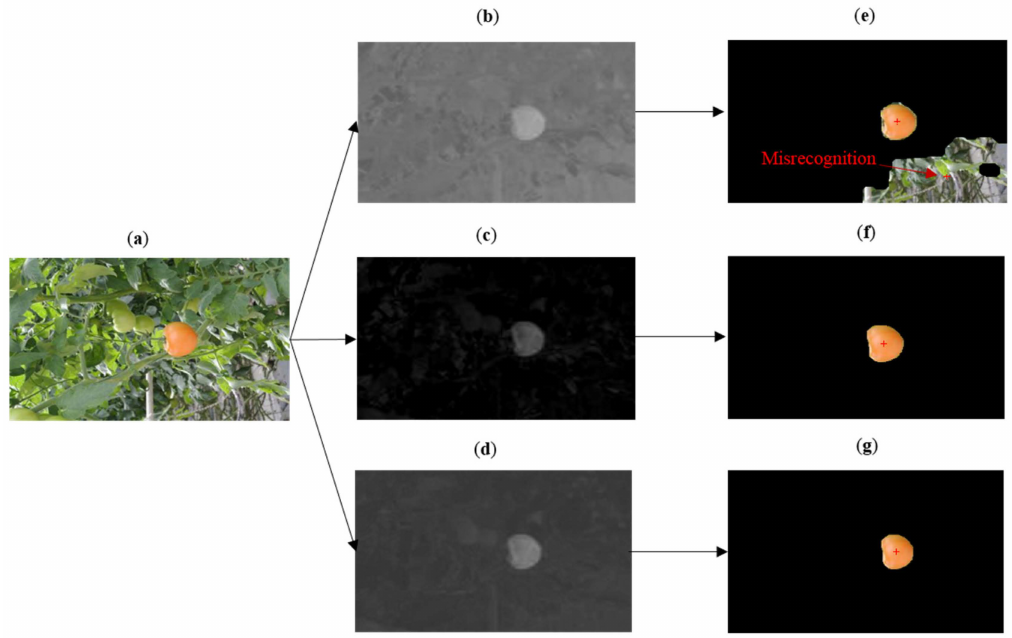
Figure 6. Contrast experiment on the disturbance of illumination. ( a ) Original image (illumination varying is obvious in the image); ( b ) a*-component image; ( c ) I-component image; ( d ) Fusion image of ( b ) and ( c ); ( e ) Recognition result of a*-component image; ( f ) Recognition result of I-component image; ( g ) Recognition result of fusion